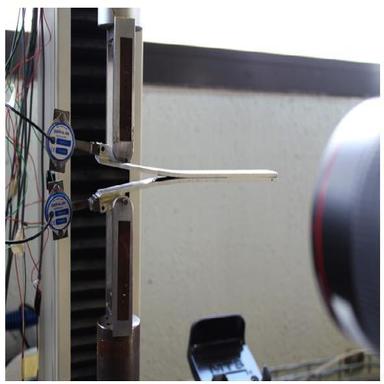
DCB specimen with inclinometers during the test.